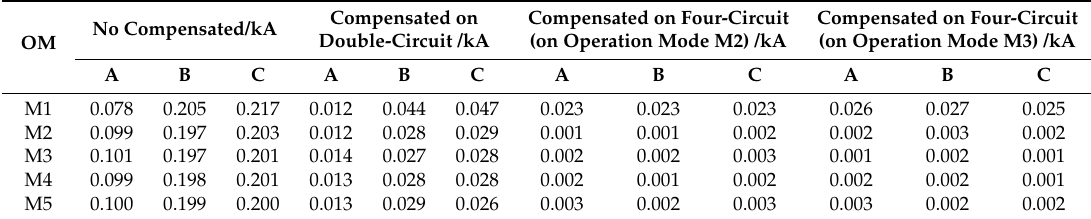
Table 2. Three-phase differential current under different operation